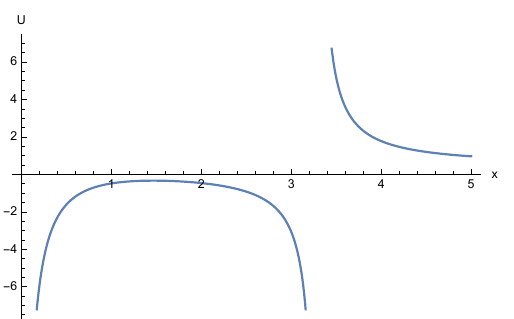
Figure 11. Plot of < U ( x ) > for x = β and G = m = R 1 = M = 1. It closely resembles the companion graph of the precedent case. However, R 0 is too large to allow for statistical bounding in the region here considered.